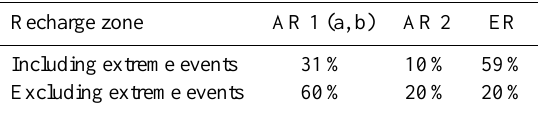
Table 4. Contribution of artificial recharge (AR 1 (a, b) and AR 2) and natural recharge (ER) zones in groundwater recharge in the pe- riod from 1993 to 2007 with and without consideration of extreme